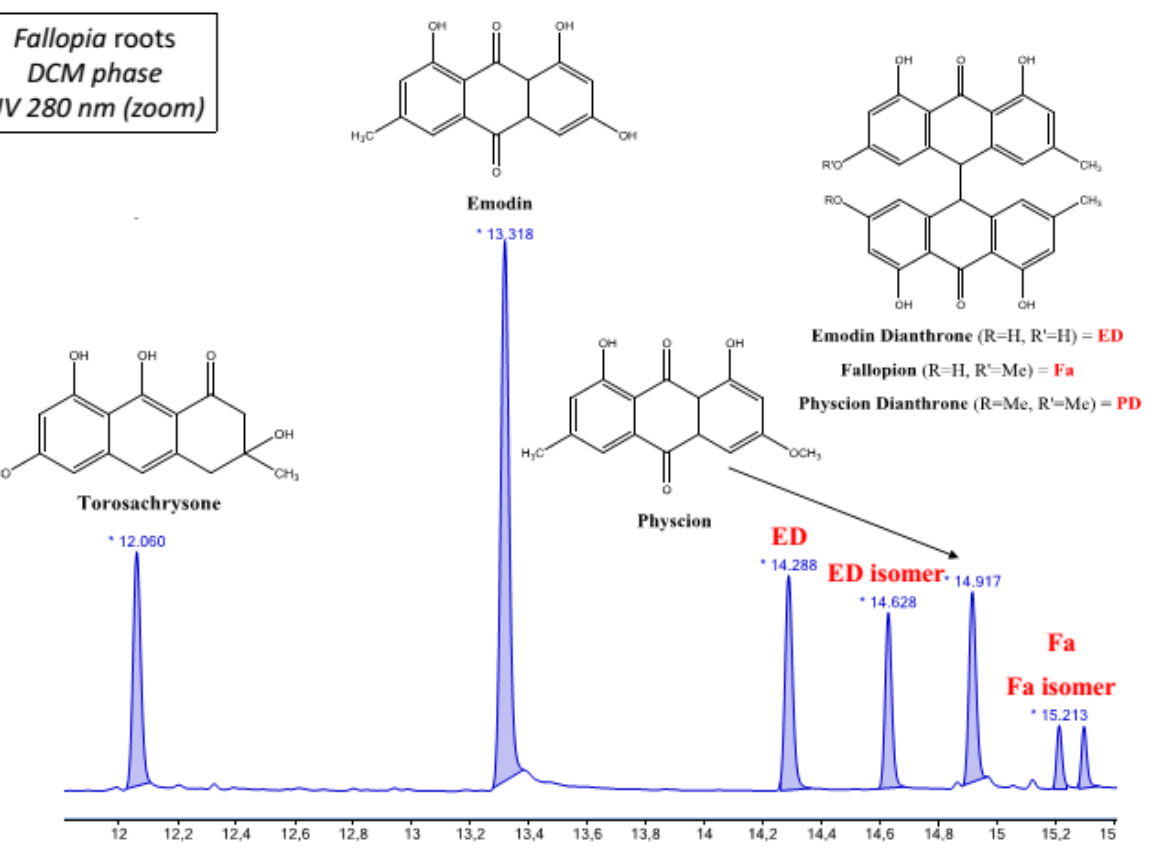
Figure A8. Chemical composition of F. japonica roots DCM fraction from the tape-strips analysis.